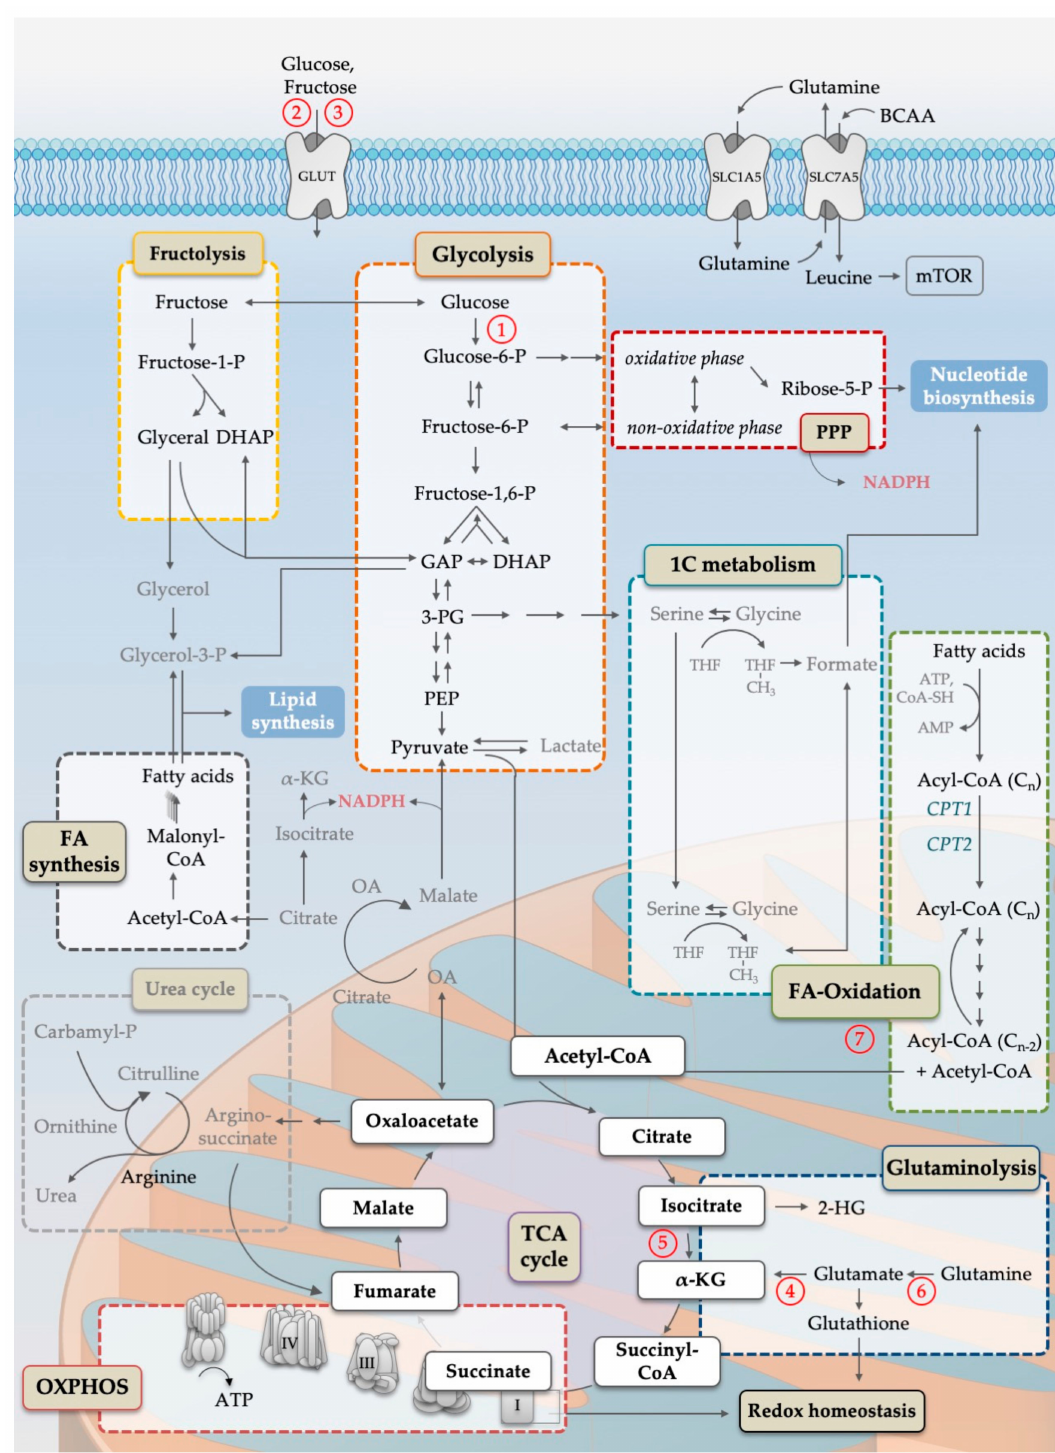
Figure 1. Simplified scheme of the cellular metabolism pathways important for AML pathophysiology. Names in colored boxes indicate major metabolic